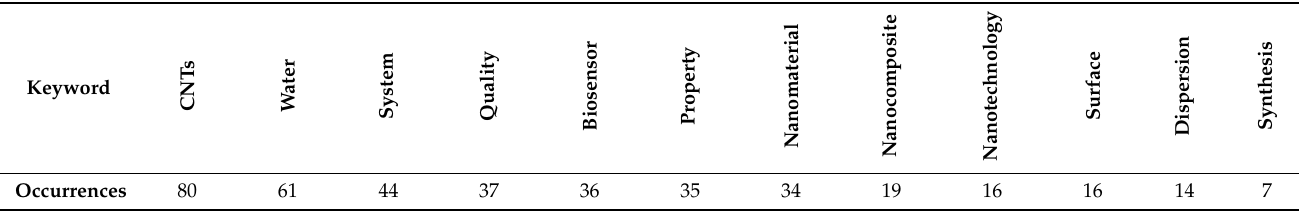
Table 4. Cluster 1 keywords and